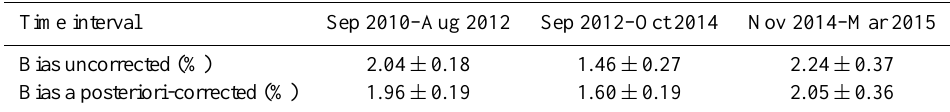
Table C1. Bias of XCH 4 monthly means between Garmisch and Zugspitze measurements and corresponding 95% confidence intervals. Results are presented for time intervals with different optical configurations and both a posteriori mispointing-corrected and uncorrected